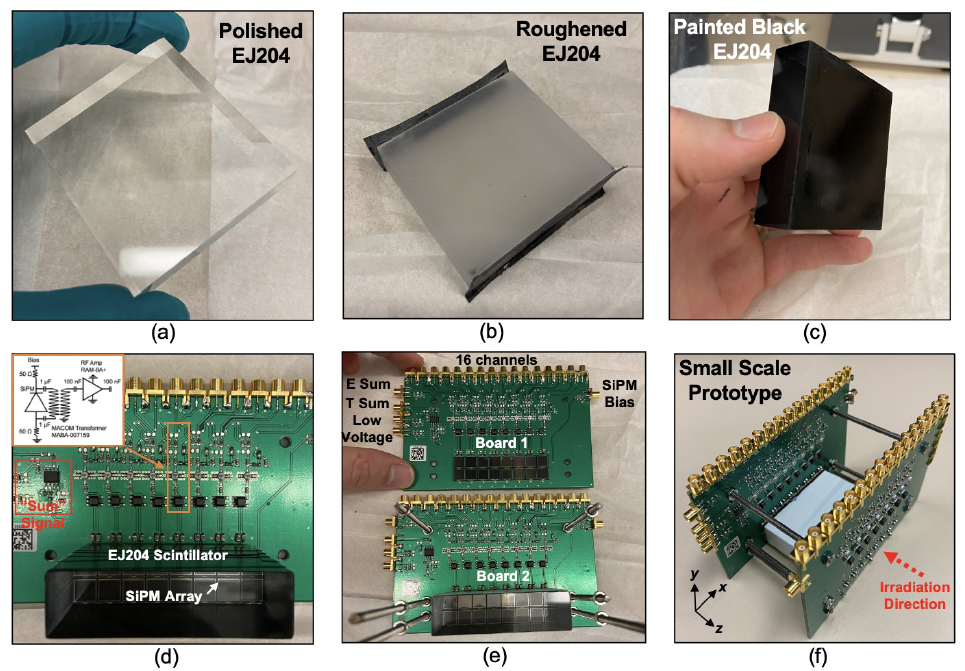
Figure 5. A piece of polished 17x55x50 mm 3 EJ-204 plastic scintillator is shown in (a). The four “side walls” of the scintillator were roughened and painted black, as shown in (b) and (c). This scintillator block, optically coupled to a prototype readout board is shown in (d). Two of these readout boards (e) were used to read out the scintillator block from both ends, as depicted in (f).